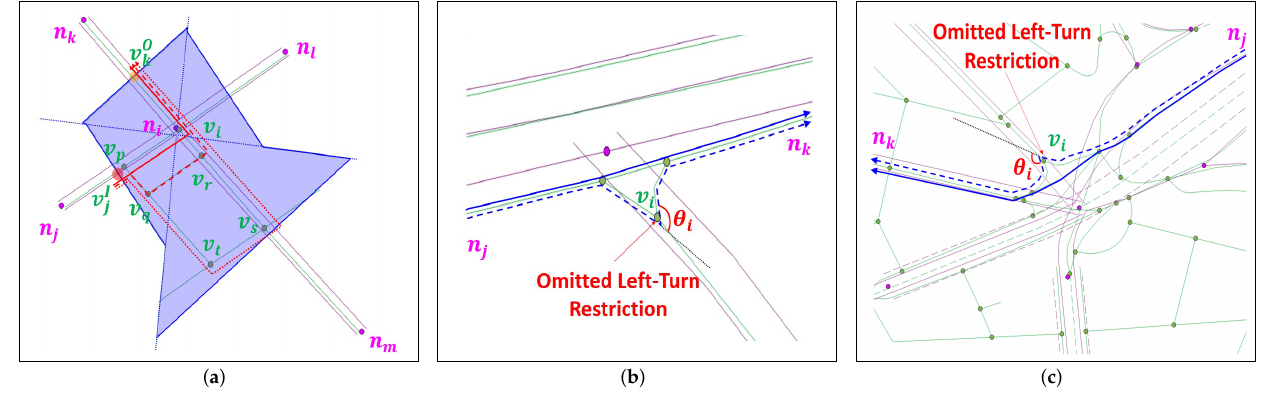
Figure 6. Candidate ORN paths between the ORN edges closest to l ji and closest to l ik at the boundary of NVAD cell V ∗ ( n i ) of ( a ) simple intersection, ( b ) exceptional case I, and ( c ) exceptional case